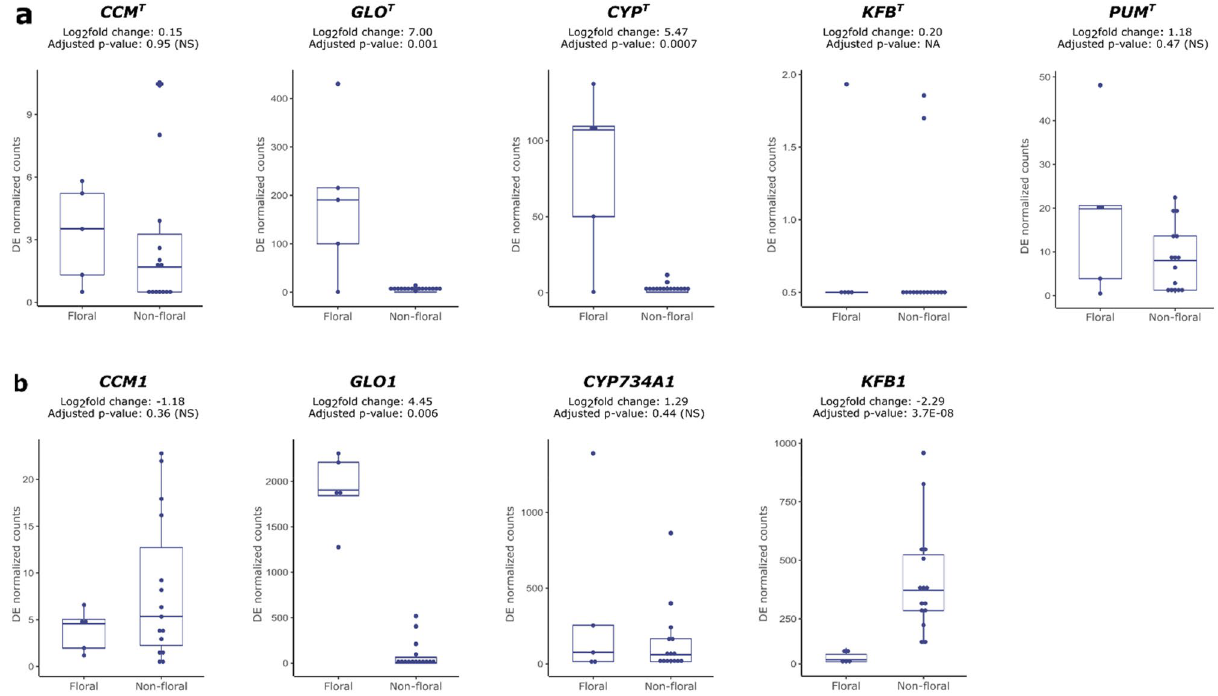
Figure 3. Expression profile of S-locus genes and their paralogs in P. veris . Box-plots showing the expression (as normalized counts) of S-locus genes ( a ) and their paralogs ( b ) in samples of floral (floral bud and flower; n = 5) and non-floral (root, seed, seedling, leaf, inflorescence stem; n = 15) tissues. For each gene, the log2fold change of expression between floral and non-floral tissues is reported together with the adjusted p value, calculated by DESeq2. NA, not applicable; NS, not